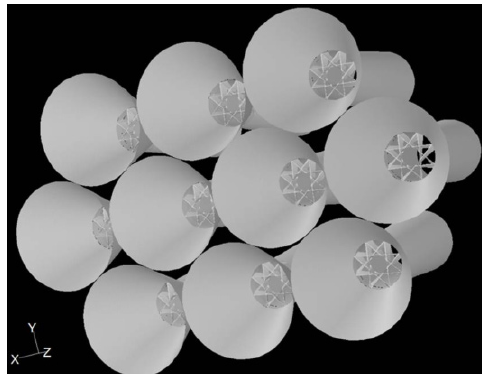
Figure 8. Modelded array of 10 CMMCT